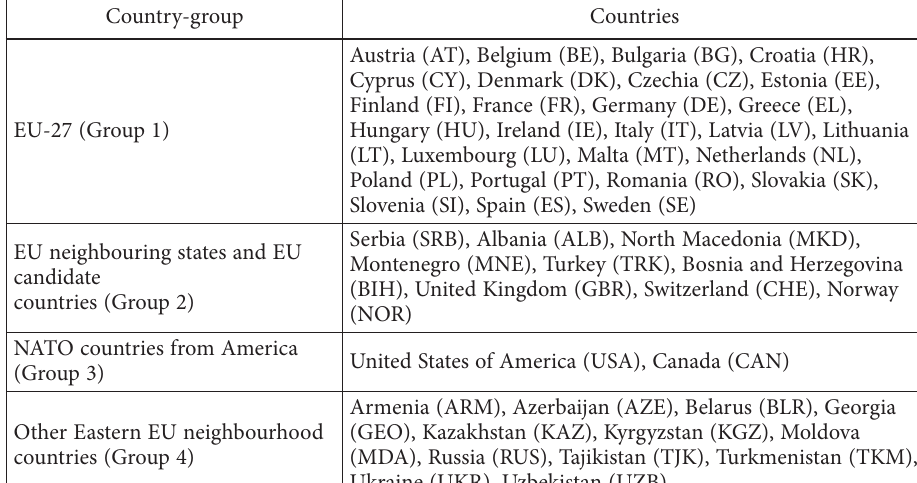
Table 1. Composition of country-groups (source: own processing using the information provided by the North Atlantic Treaty Organization, 2022) Country-group Countries